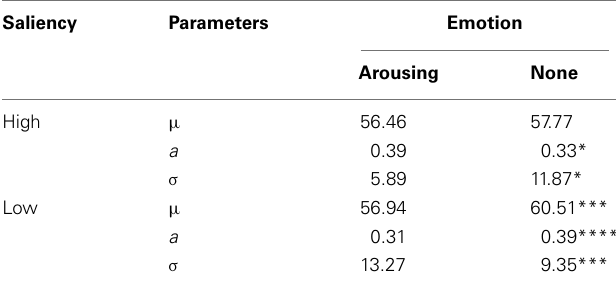
in probe trials for the arousing versus the non-arousing sessions and p values from the comparisons of each parameter using nested model